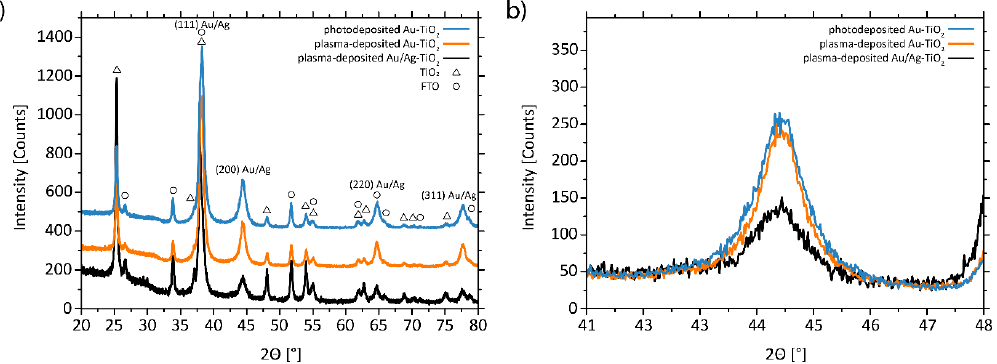
Figure 1. ( a ) Grazing incidence X-ray (GIXR) diffractograms of the three noble metal-decorated